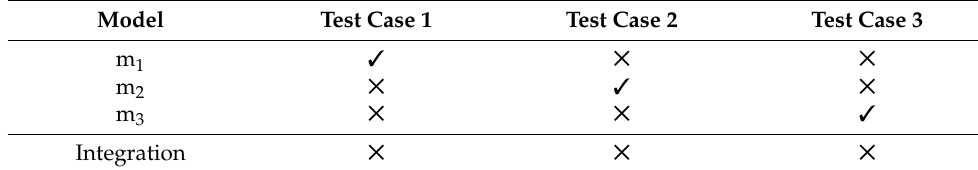
Table 4. Integration has a “negative